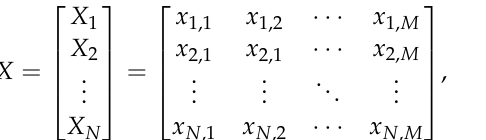
Figure 2 provides the flow chart of the original NGO